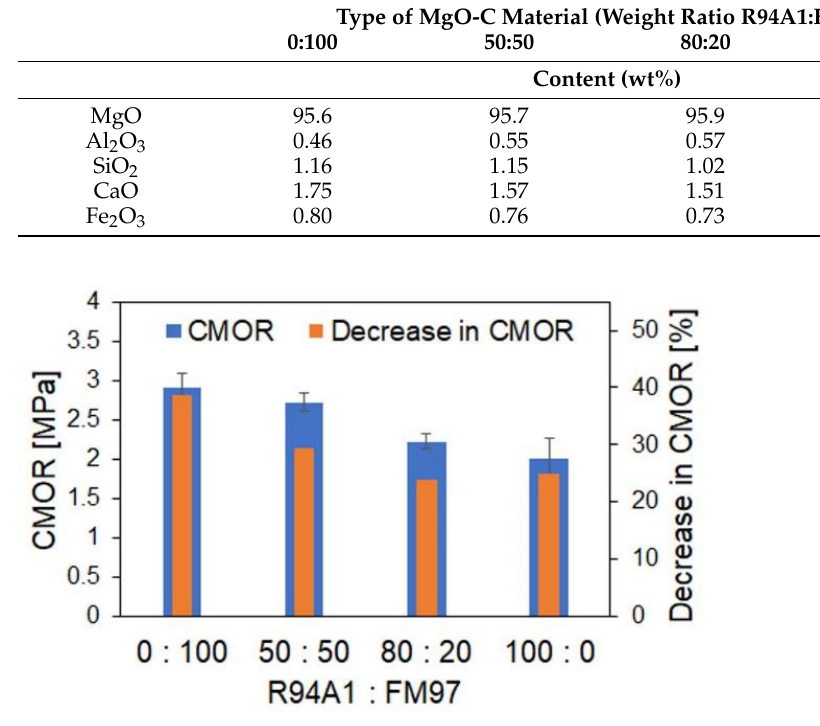
Figure 8. Cold modulus of rupture (CMOR) of coked MgO-C specimens depending on the used weight ratio of recyclate R94A1 to fused magnesia FM97 and decrease in CMOR as a result of five thermal shocks.